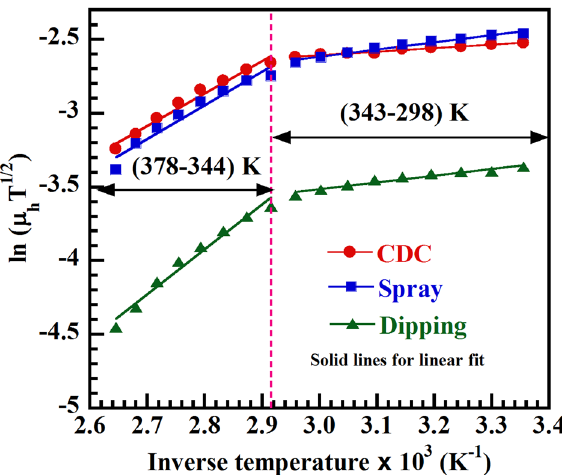
Figure 4. Figure for calculating grain boundary parameters. ln (μ h T 1/2 ) vs 1/T graph for CDC, spray and dipping deposited CH 3 NH 3 PbI 3−x Cl x thin films.